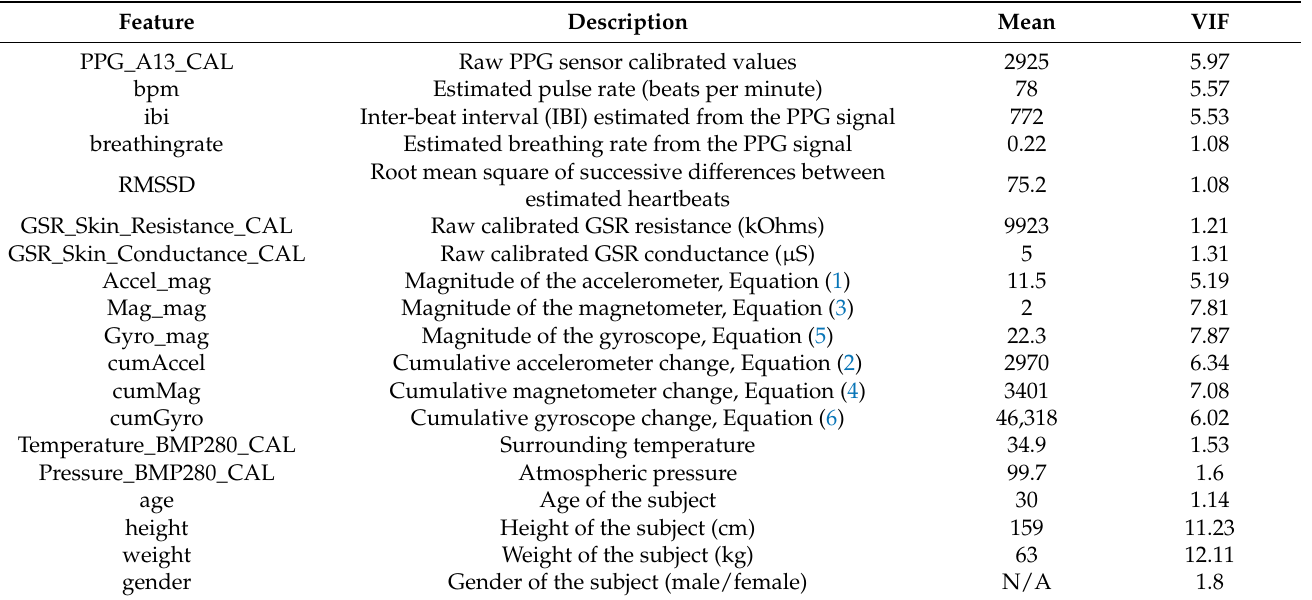
Table 2. List of